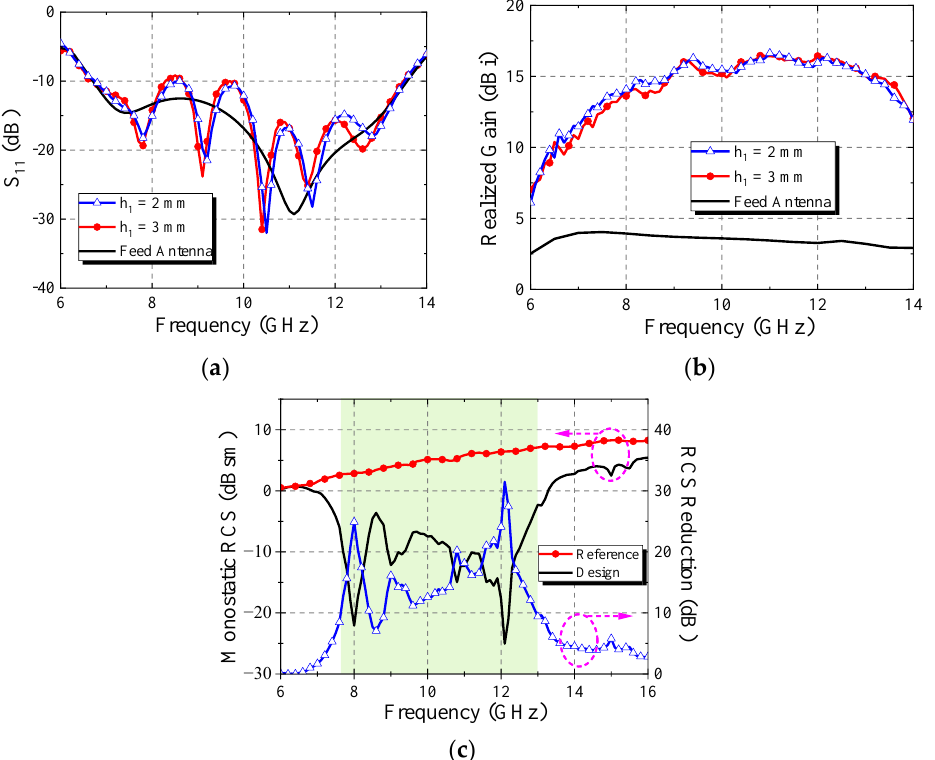
Figure 17. Simulation results of antenna: ( a ) S 11 curve; ( b ) realized gain; ( c ) RCS reduction effect in X band.